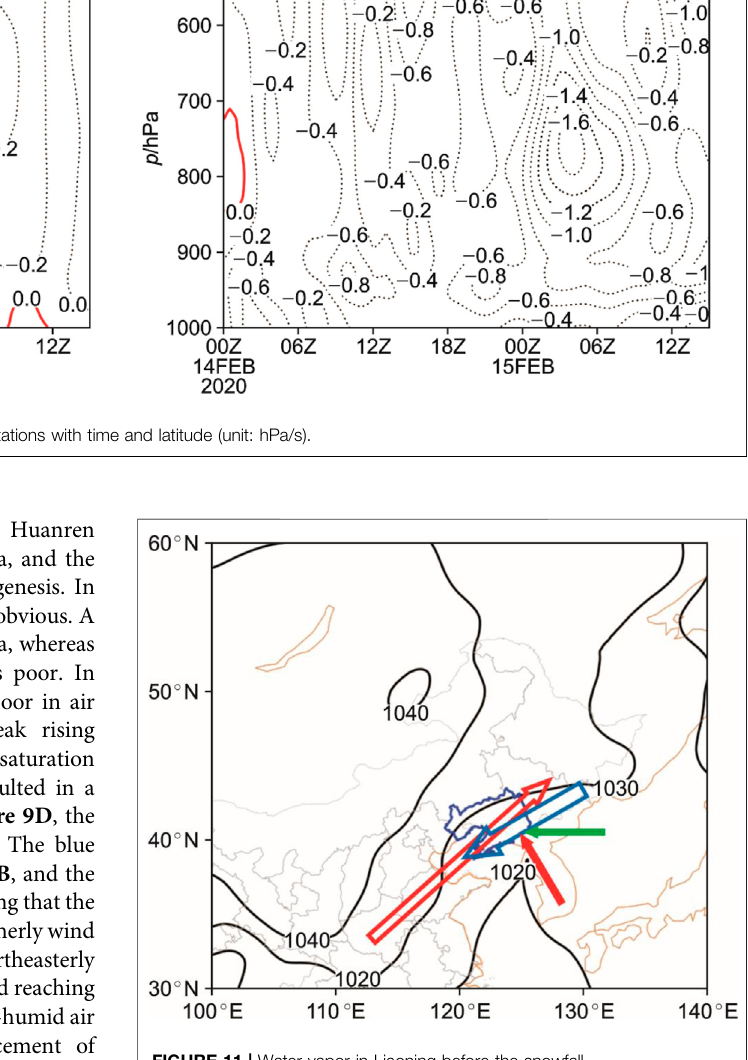
FIGURE 11 | Water vapor in Liaoning before the